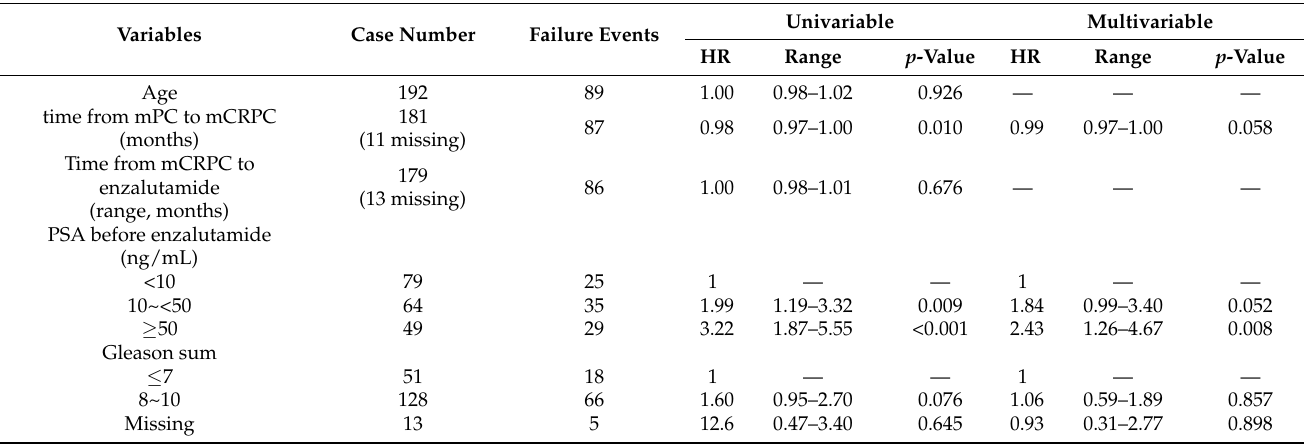
Table 4. Univariable and multivariable analyses of progression-free survival duration to enzalutamide in metastatic castration-resistant prostate cancer